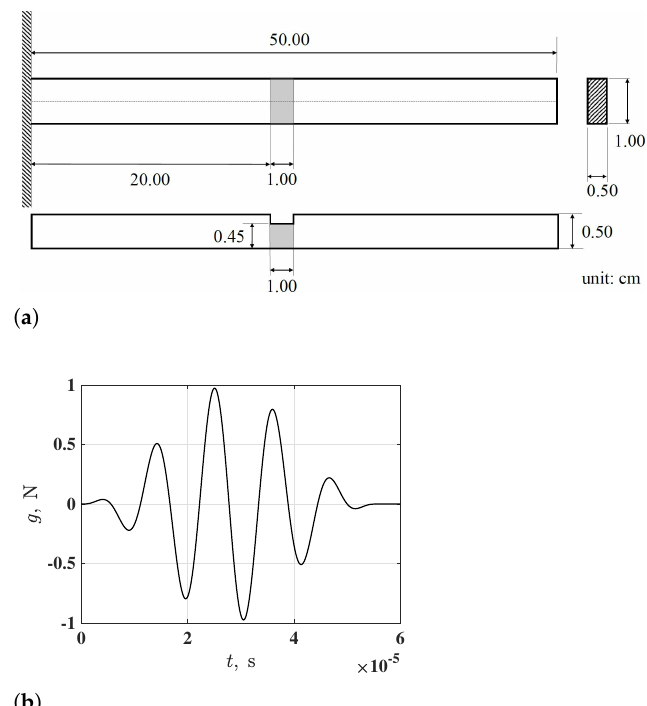
Figure 1. ( a ) Dimensions of a damaged cantilever beam with damage in the form of a one-sided thickness reduction area and ( b ) an excitation force in the form of a 5-count wave